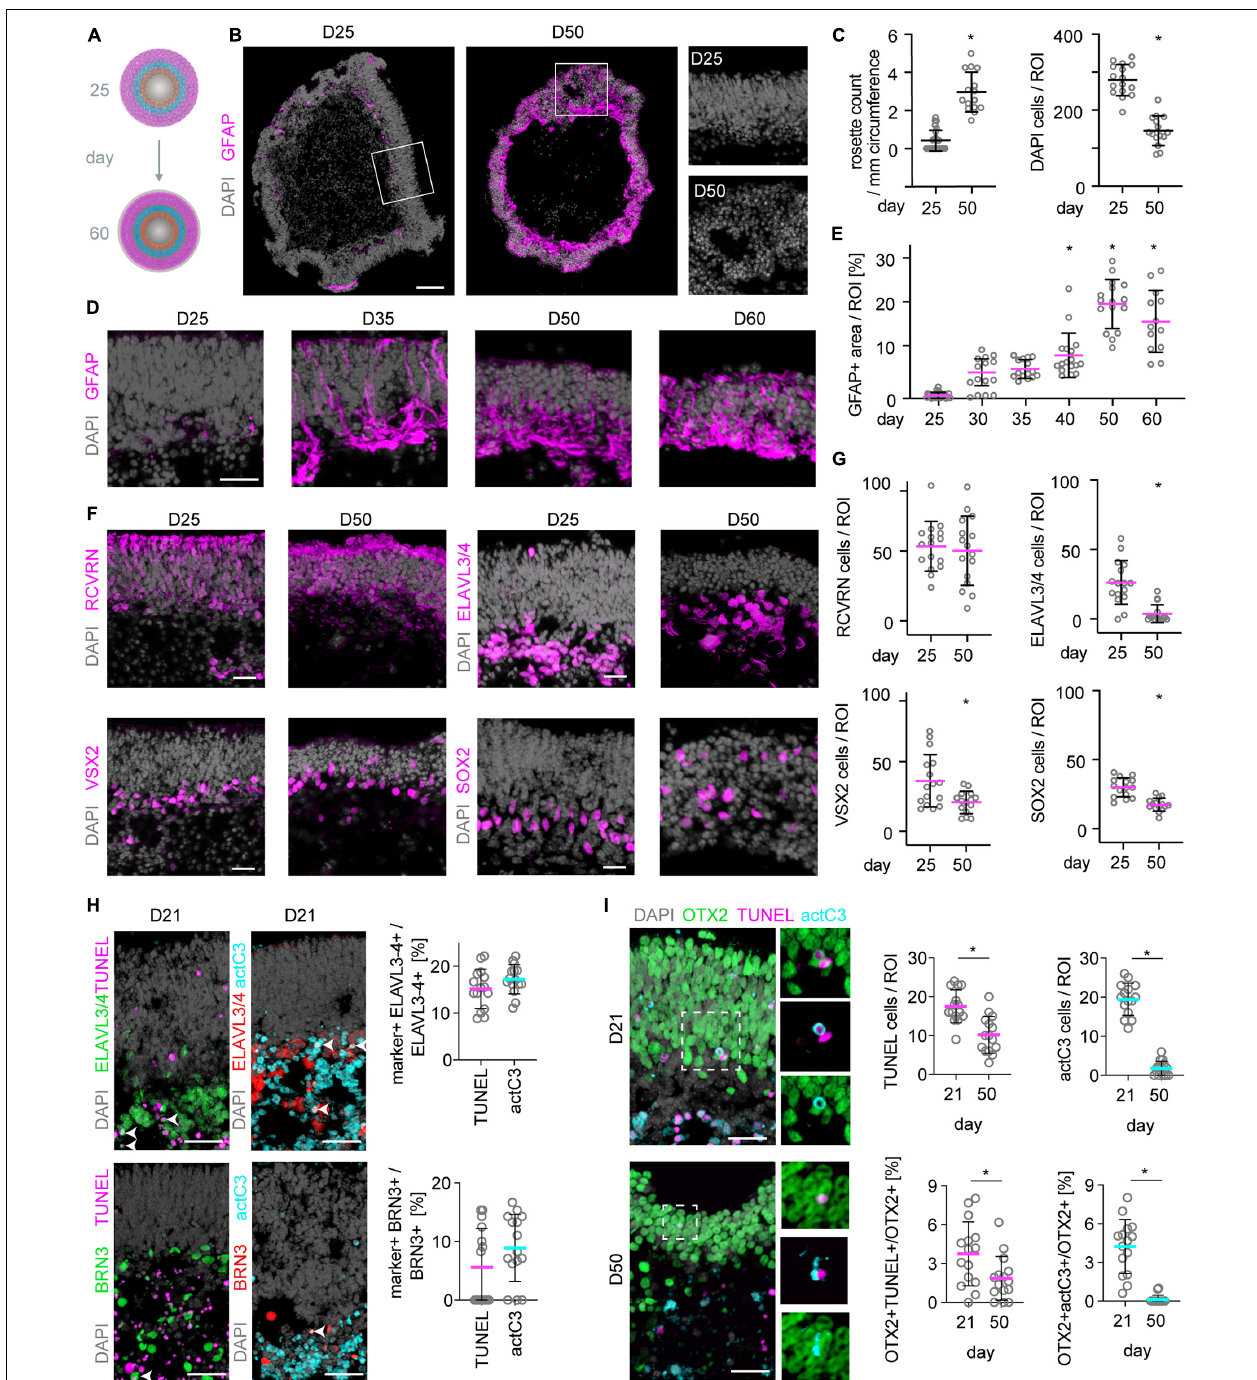
FIGURE 7 | Neuronal cell death and reactive gliosis in postmitotic MROs. (A) Scheme experimental paradigm: MRO were assessed between day (D) 25 and 60 at the timepoints indicated in the figure. (B,D) Mouse retina organoid (MRO) cryosections were immunostained for gliosis hallmark GFAP and DAPI. At D25, no (or very little) GFAP is detected, but it becomes upregulated at later timepoints, suggesting the onset of reactive gliosis. Further, MROs at D25 show continuous long epithelia (B) , but at later timepoints (D50, B ) epithelia become less organized and rosettes are frequently observed. Squares indicate regions shown at higher magnification. (C,E) Quantification of data presented in (B,D) . Each dot represents an organoid. (F) Staining for photoreceptor (RCVRN), inner neuron (ELAVL3/4), bipolar cell (VSX2) and Müller glia (SOX2) markers at D25 and D50 shows that inner neurons, bipolar cells and also Müller glia are reduced in numbers at later timepoints. In contrast, photoreceptor numbers remain similar at both timepoints. Notably also the total cell number (DAPI) decreases (C) . Further, the different cell types become displaced from their originally defined layers and more distributed, reflecting the epithelial disorganization and rosetting at later timepoints already noted